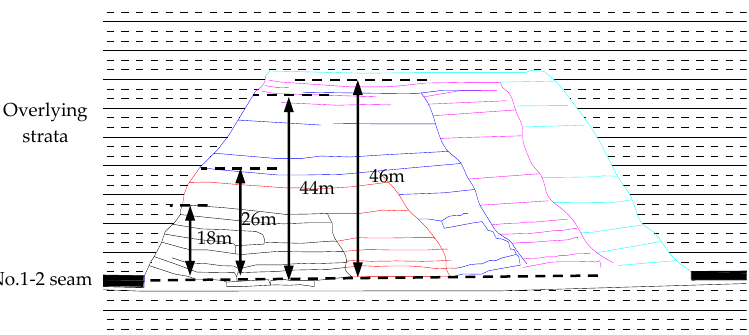
Figure 14. Sketch drawing of evolution of DPC in N1114 working face mining.